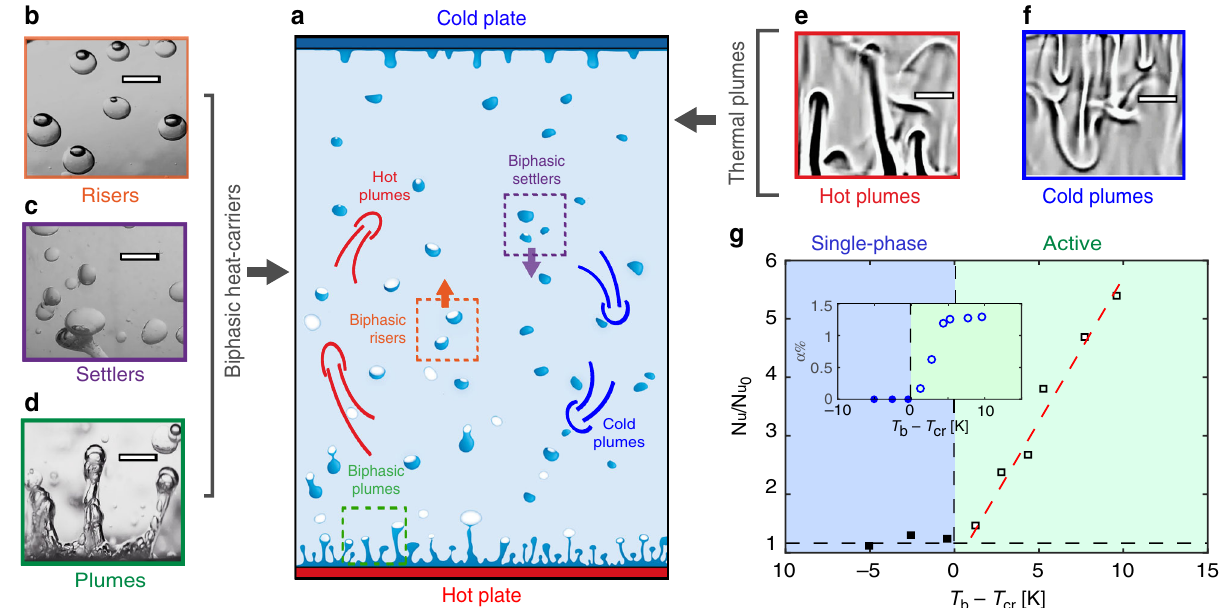
Fig. 1 Active biphasic particle turbulence. a Schematic of a classical thermal turbulence set-up with water as working liquid, and augmented by ~1% volume of active species: HFE-7000. Insets b – d show novel heat carriers of the system: b biphasic risers, c settlers, and d plumes (see Supplementary Movie 1 and 2). Insets e , f show shadowgraphy images of the classical heat transporters of thermal turbulence, namely e hot and f cold thermal plumes (see Supplementary Movie 3). Inset scale bars: 6 mm. g Heat fl ux enhancement expressed as the ratio of Nusselt numbers Nu/Nu 0 vs. temperature difference T − T b cr . Here, Nu is the Nusselt number of the current system, Nu 0 is the Nusselt number of classical thermal turbulence, temperature, and T cr is the boiling point of HFE-7000 liquid above which the dynamic evaporation-condensation cycles begin. The blue shaded area corresponds to the single phase regime, almost identical to classical thermal turbulence, and the green-shaded area the active regime. Inset shows the vapor phase of the biphasic species volume fraction α (see Suppl. Mat.) as function of T b − T cr . The experiments were conducted at fi xed bottom and top plate temperature difference Δ T ≡ T b − T t in order to maintain Rayleigh number almost state of intermediate frequency and amplitude temperature fl uctuations (inset (data plot) to Fig. 2c), which optimally